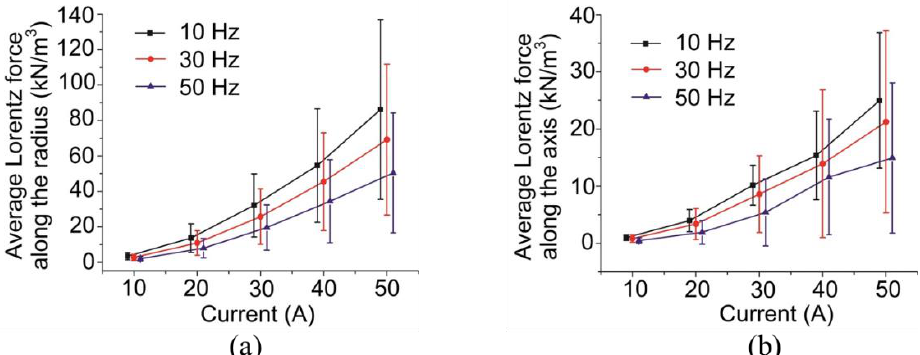
Figure 11. Average Lorentz force along the ( a ) radius and ( b ) axis at different winding currents and electrical frequencies. Error bars indicate the standard deviation of the average Lorentz force.